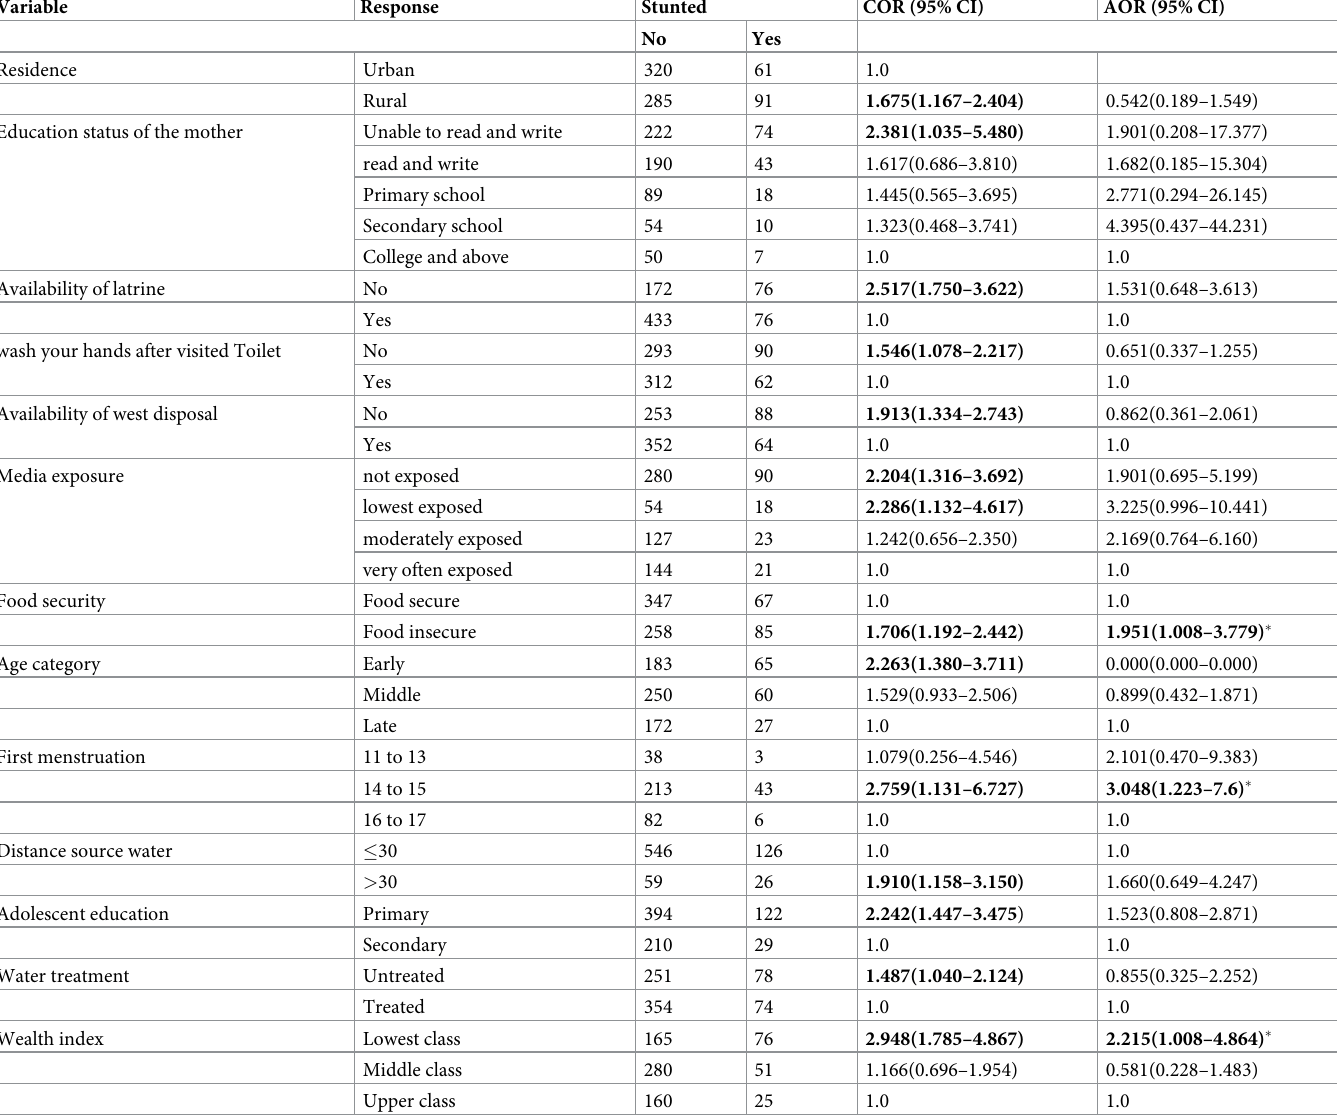
Table 5. Bivariable and multivariable logistic regressions of overall factors associated with over stunting among school adolescent girls in Debark district, 2020 (n =